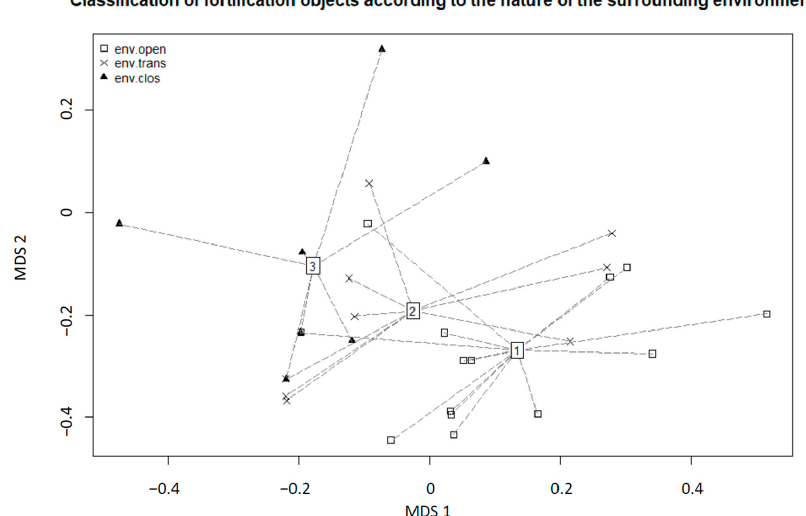
Figure 7. Ordination diagram (MDS) showing the distribution of individual SA ‐ CEFs as a function of the nature of the surrounding environment (butterflies and moths, for all SA ‐ CEFs, without data adjustment).